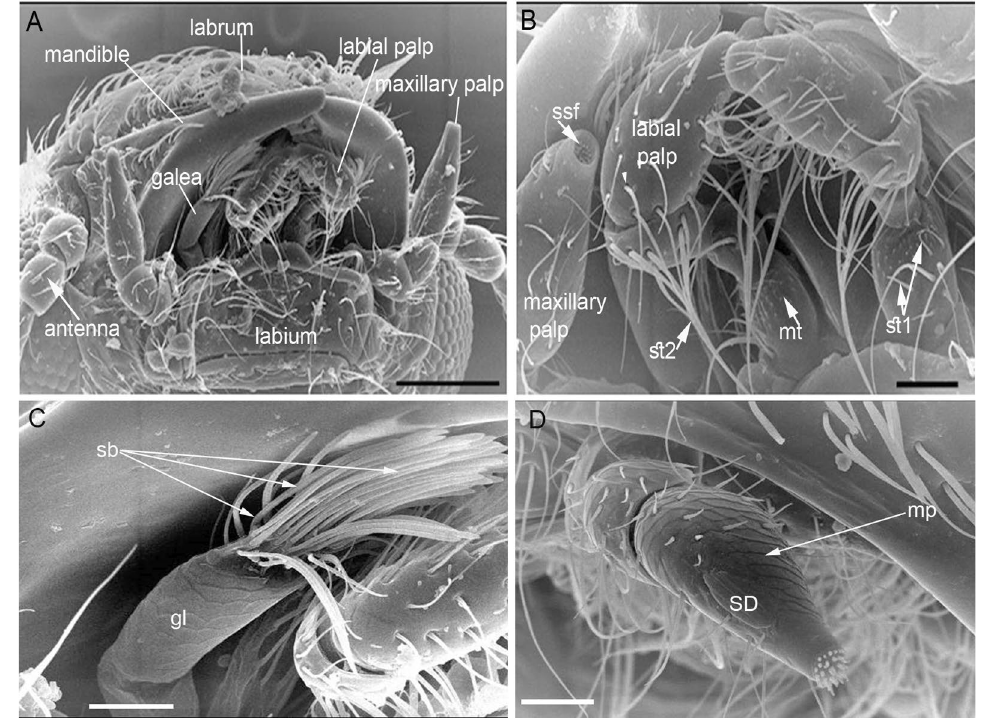
Fig. 5 Scanning electron micrographs (SEM) of the ventral view of the mouth parts of adult Rhyzopertha dominica with associated sense organs. A Mouth parts showing the labrum, mandibles, maxillae carry two four-segmented maxillary palps and lateral galea fringed with a dense comb of large basiconic sensilla, and the labium with two five-segmented labial palps. B Higher magnification of the labial palp showing the sensory field of their distal segments having numerous short and long s. trichodea (st1 and st2); note that the second segment of labial palp carried many cone shaped microtrichea (mt). C Galea of maxilla (gl) fringed with a dense field of long s. basiconica (sb) and the distal segment of the maxillary palp (mp) surrounded with numerous long s. trichodea (st2). D Lateral view of the head showing antenna (ant), labrum (lb), mandible (md) and labial palp (lp). scale bars: A 50 μm; B–D 10 µm